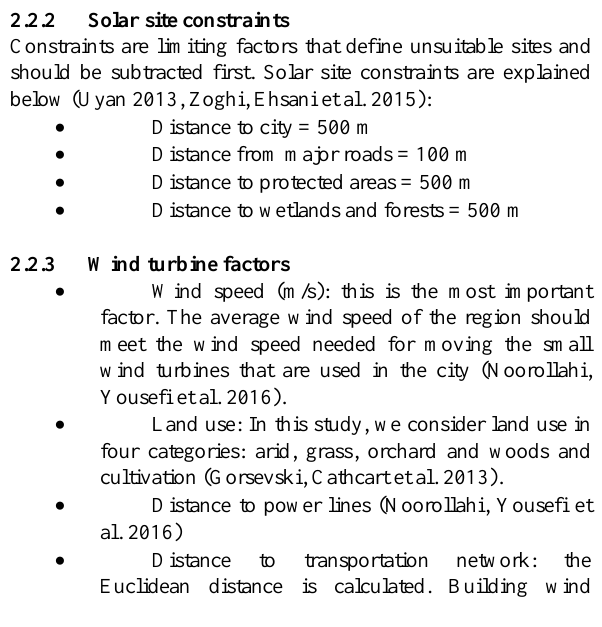
Figure 2. Criteria and factors for solar site